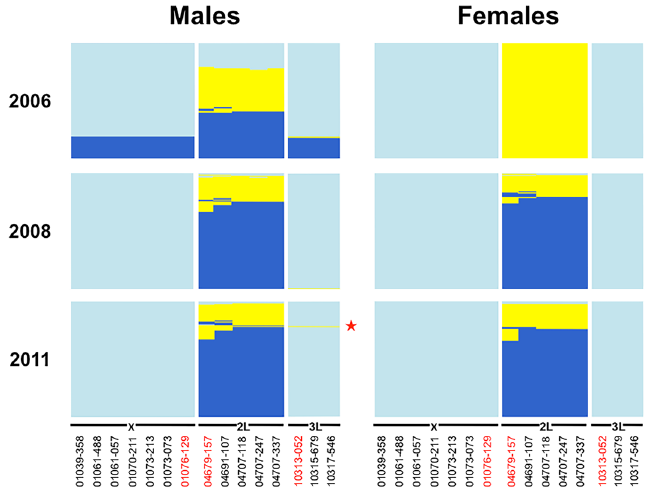
Figure 2. DIS map of males and females Anopheles coluzzii and An. gambiae collected from swarms in the village of VK7 in Burkina Faso—DIS genotypes specific to An. coluzzii (light blue) and An. gambiae (dark blue) are shown; heterozygous DIS genotypes are in yellow—SNPs nearest to centromeres are in red lettering. One F 1 hybrid male with An. coluzzii maternal X-island was identified in 2011 (red star).